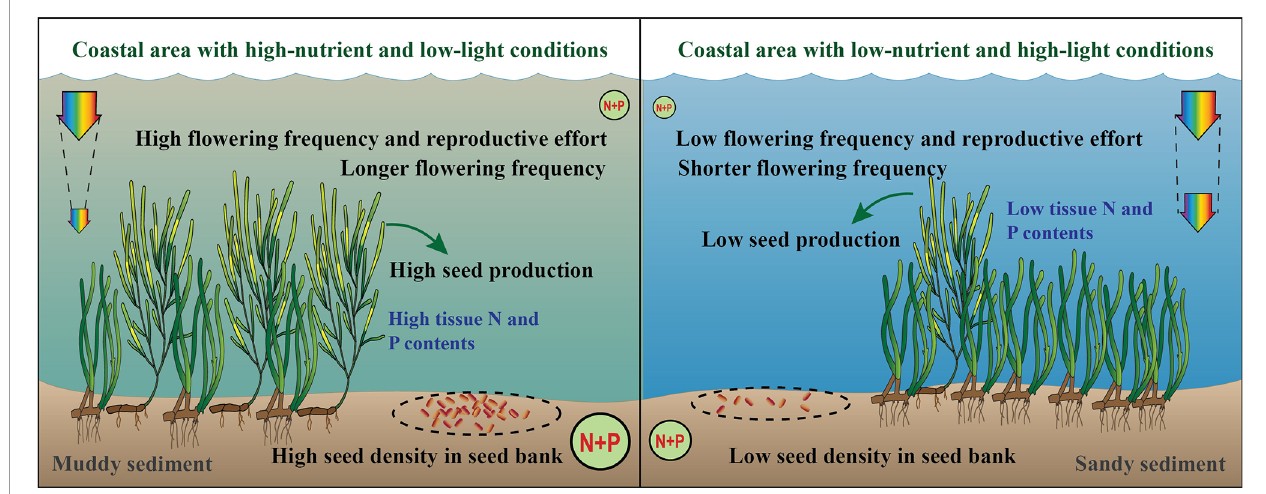
FIGURE 6 | A summary of the reproductives responses of Z. marina to changes in nutrient and light availability. Diagram symbols are from the Integration and Application Network, University of Maryland Center for Environmental Science